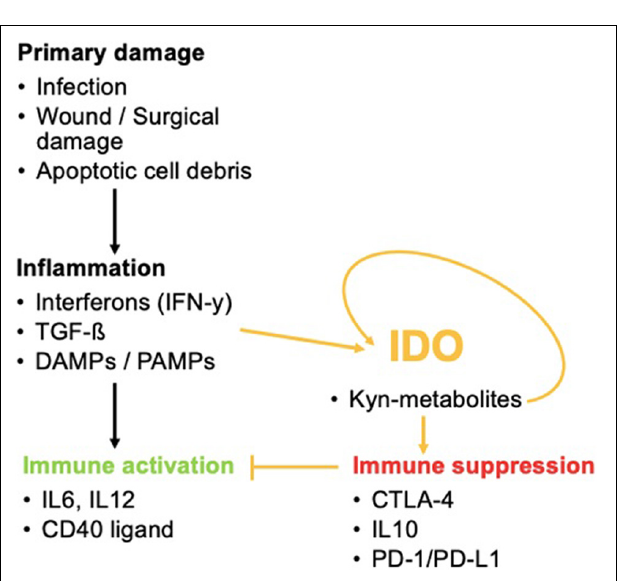
FIGURE 3 | The role of IDO in inflammatory processes. IDO activation by inflammation favors immune tolerance and hinders immune activation that would normally occur via the activation of pro-inflammatory cytokines. IDO can even promote its own activity once